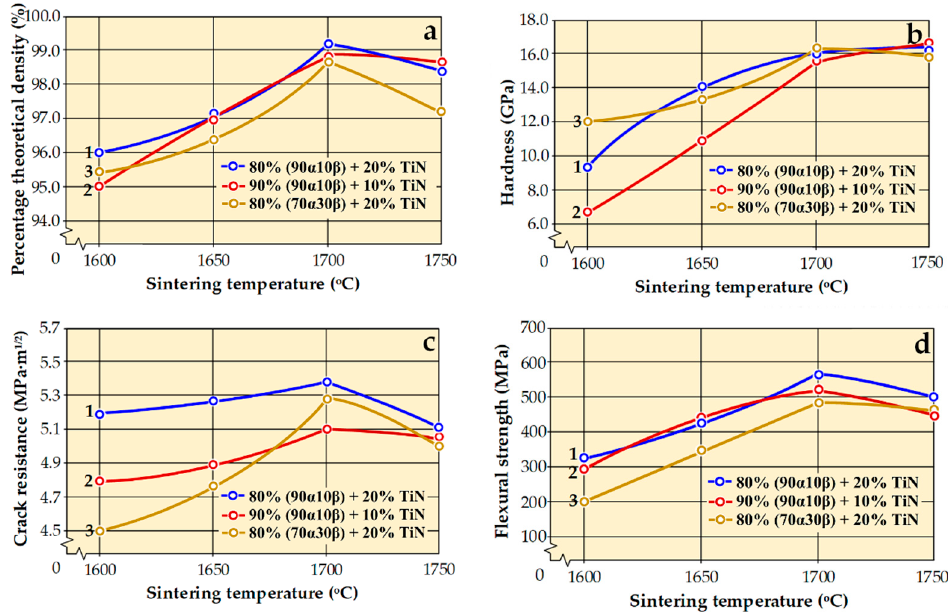
Figure 9. Dependences of the basic physical and mechanical properties of sintered ceramic samples made of various powder compositions such as 80% (90 α 10 β ) + 20% TiN (1), 90% (90 α 10 β ) + 10% TiN (2), and 80% (70 α 30 β ) + 20% TiN (3) from the spark plasma sintering temperature: ( a ) percentage theoretical density; ( b ) hardness; ( c ) crack resistance; and ( d ) flexural strength.